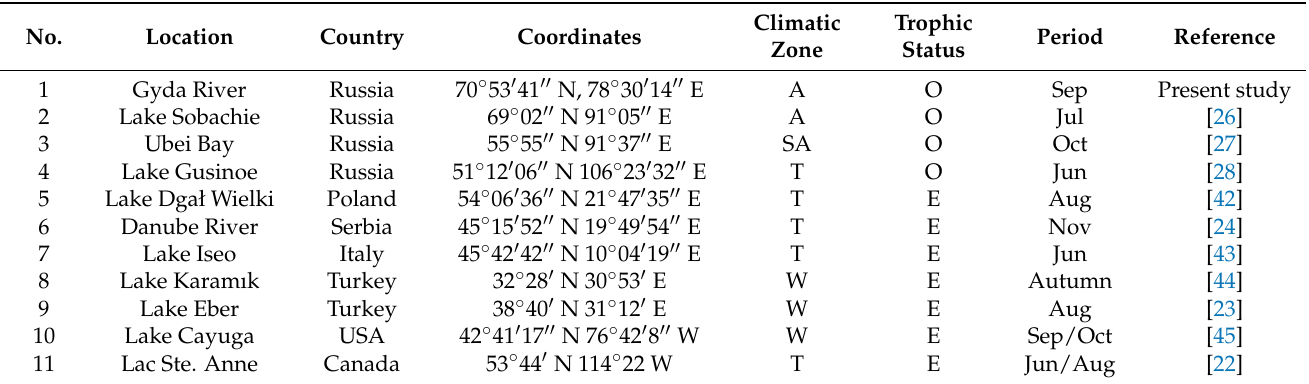
Table 1. Information on water bodies inhabited by pike populations used for spatial comparisons of fatty acid profiles.